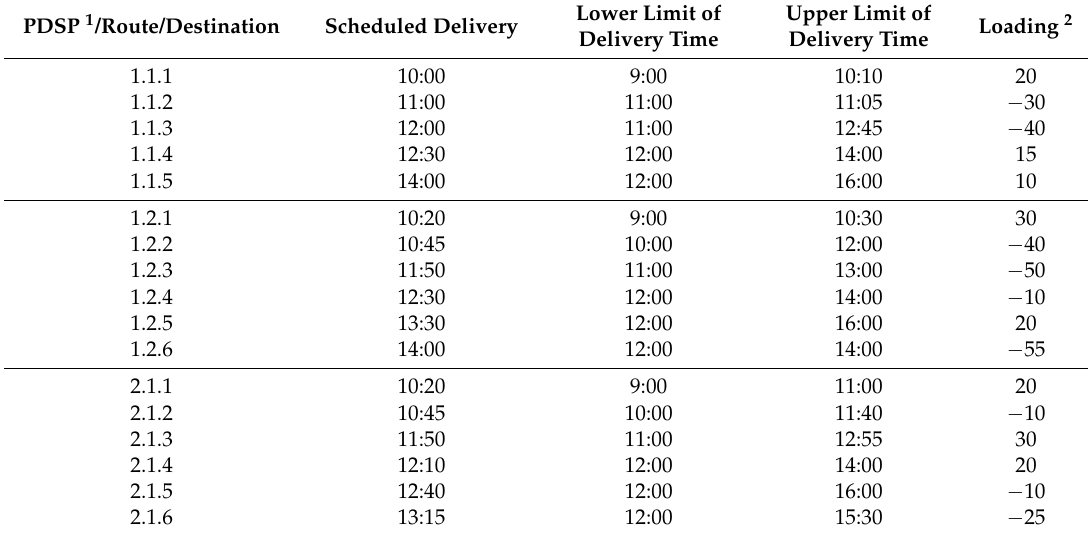
Table 3. Time frame parameters and package volumes of scheduled deliveries of the